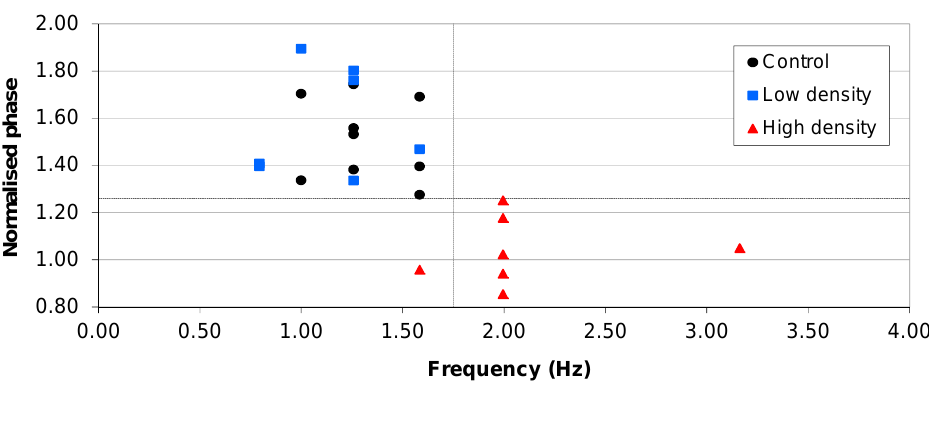
Figure 6. The magnitude and frequency of the normalised phase angle peak from all 24 vials from the parallel suspension experiments. The majority of the vials with cell densities that reached above 1 × 10 7 CFU·mL − 1 occurred in the lower right quadrant, while the media only and lower density vials occurred in the upper left